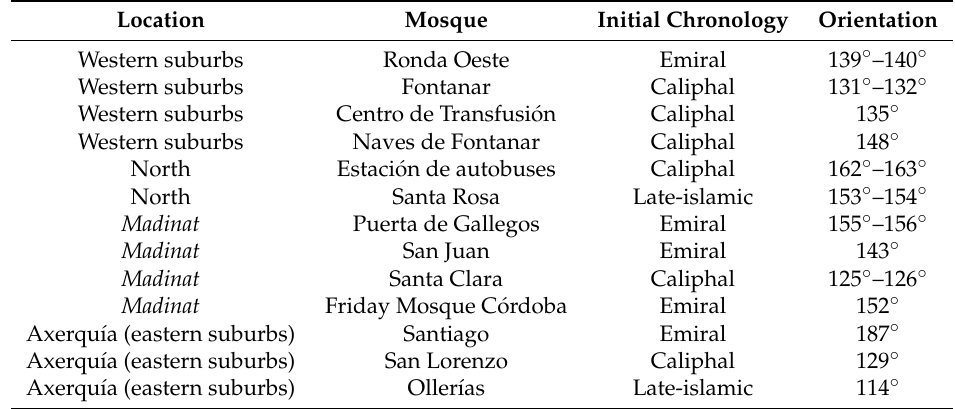
Table 1. Mosques documented in C ó rdoba: relation among their locations, chronologies and qibla